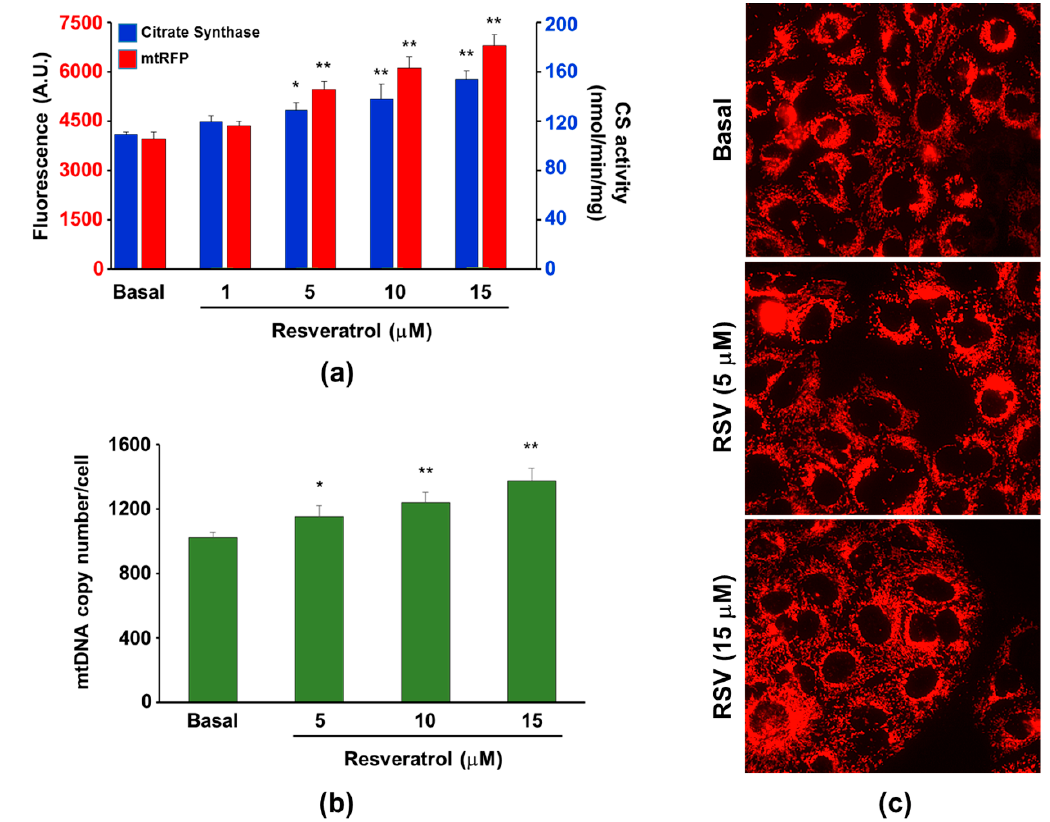
Figure 6. Mitochondrial mass evaluation in 143B-Clone E cells exposed for 48 h to increasing concentration of RSV. ( a ) Relationship between the mean fluorescence intensity values (red bars) and the CS activity (blue bars) measured in cells cultured in the absence or in the presence of increasing RSV concentration. ( b ) Cellular mtDNA content evaluated in the presence of different RSV concentrations. Histograms show the mean ± SD of three different experiments. * p < 0.05 and ** p < 0.01 indicate the statistical significance of data. ( c ) Representative fluorescence microscopy images (magnification 40×) of cells cultured in either the absence or presence of RSV.